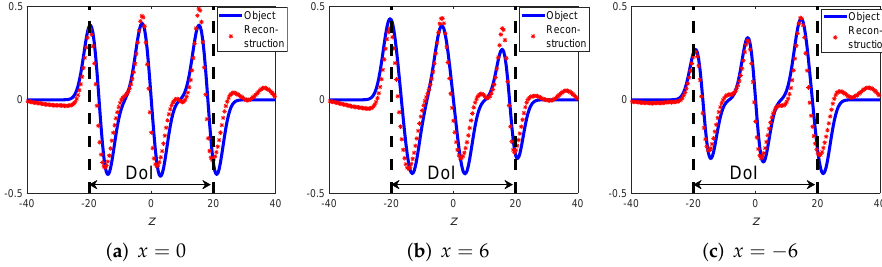
Figure 8. Example A: Comparison of the results along cross sectional cuts parallel to the z